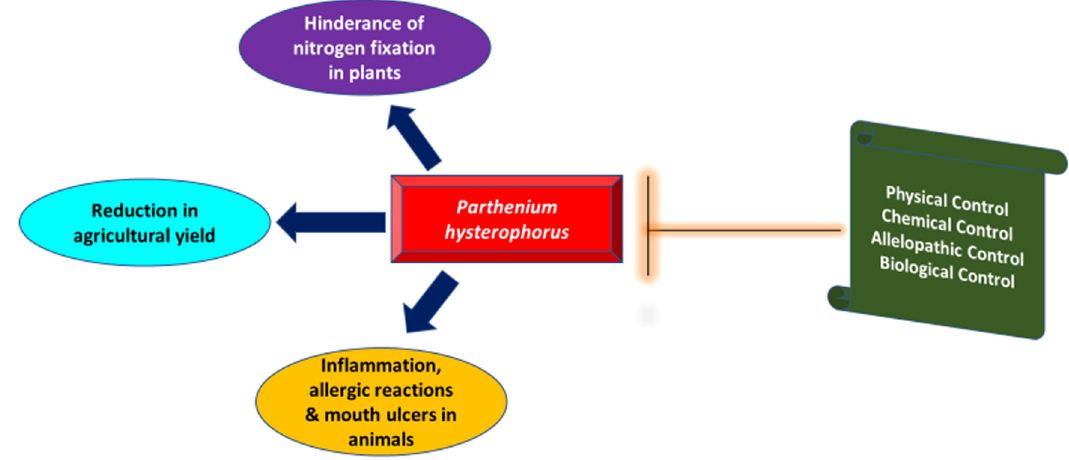
Figure 2: Representation of the overall harmful e ff ects of P. hysterophorus and its control